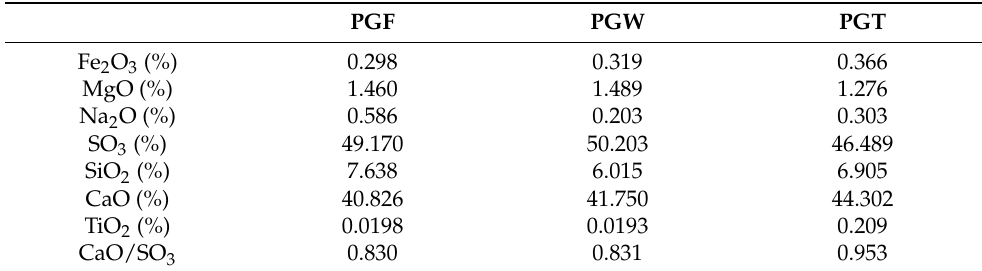
Table 3. Chemical composition of the different phosphogypsum samples. PGF PGW PGT Fe 2 O 3